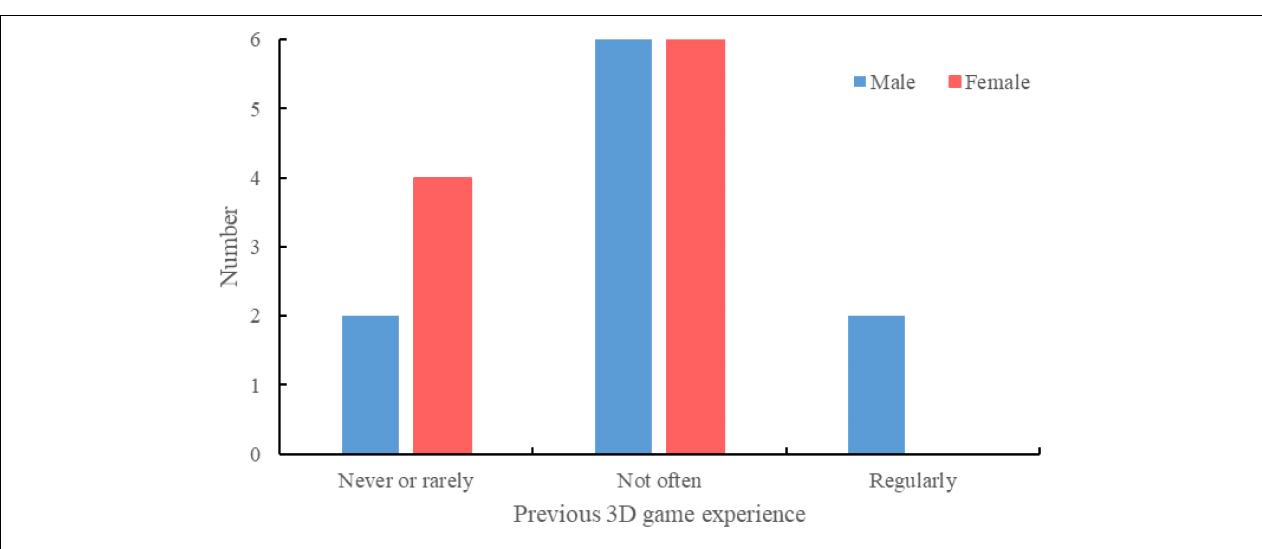
FIGURE 6 | Previous 3D gaming experience of